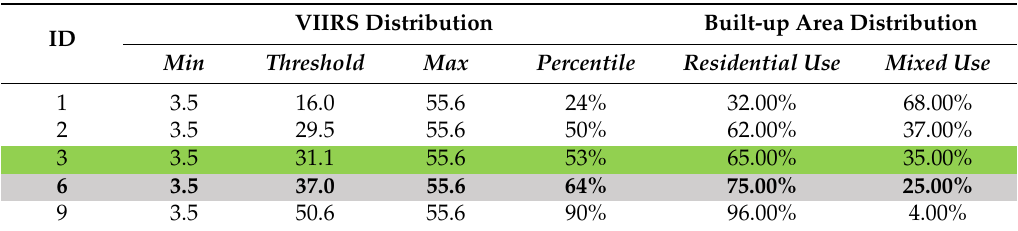
Table 5. VIIRS distribution thresholds (original 15 arc-sec grid) and corresponding building use distribution ratios using the monthly composite for May ratios (grey indicating selected best-matching threshold, green indicating previously identified June threshold for